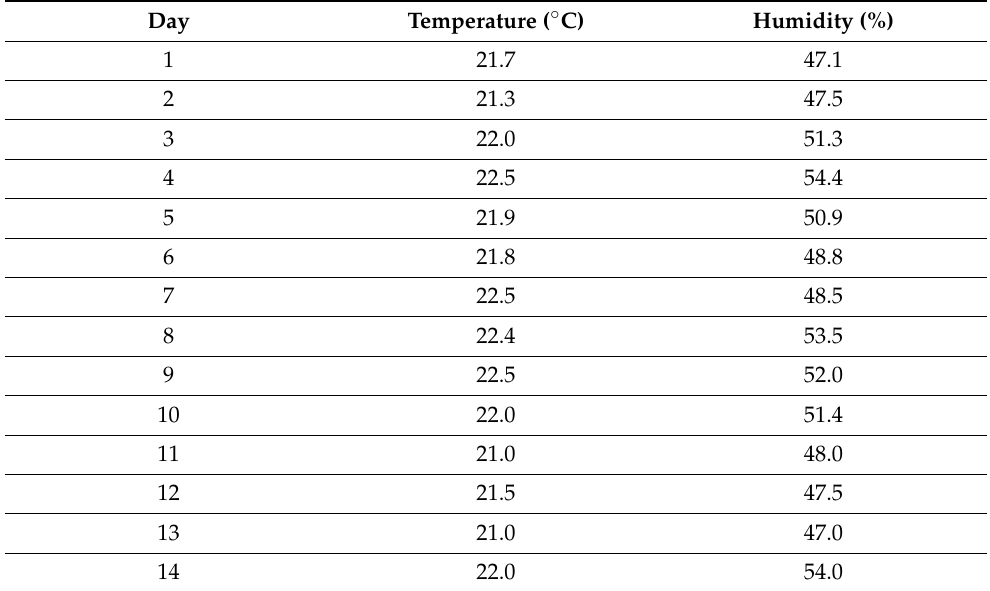
Table 6. Temperature and humidity during the 14-day monitoring campaign.